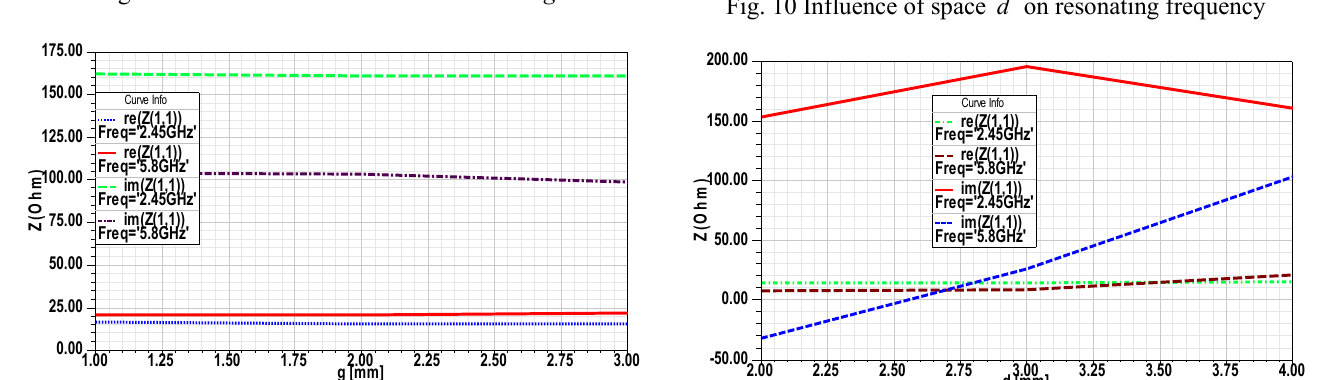
Fig. 6. Return loss S11 with different width g